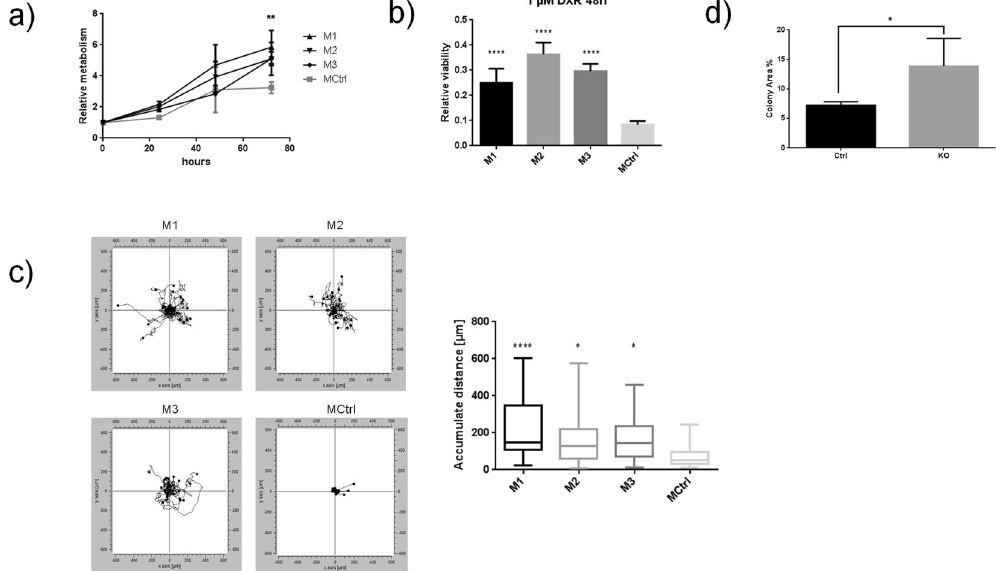
Figure 5. Biological data to validate the predicted phenotype. ( a ) Analysis of the relative increase of metabolic activity via MTT-Assay, normalized to each starting point, *** p ≤ 0.001 for M1 and ** p ≤ 0.01 for M2 and M3 compared to MCtrl, N = 4, two-way ANOVA with Dunnett’s multiple comparison. ( b ) Treatment with 1 µ M doxorubicine for 48 h and analysis of viability as by CTG assay, N = 6, **** p ≤ 0.0001 compared to Ctrl, two- way ANOVA with Bonferroni’s multiple comparison). ( c ) Analysis of colony forming abilities via the clonogenic assay shows a significantly higher colony area in the KOs after seven days of incubation, student’s t-test, p ≤ 0.05, N = 3 or 9, images in supporting Figure S7. ( d ) Single cell tracking measurement for evaluation of the migratory potential, displayed as accumulative distance after 20 h, N = 30, **** p ≤ 0.0001, * p ≤ 0.05 compared to MCtrl, one-way ANOVA with Dunnett’s multiple comparison after outlier test, velocity displayed in